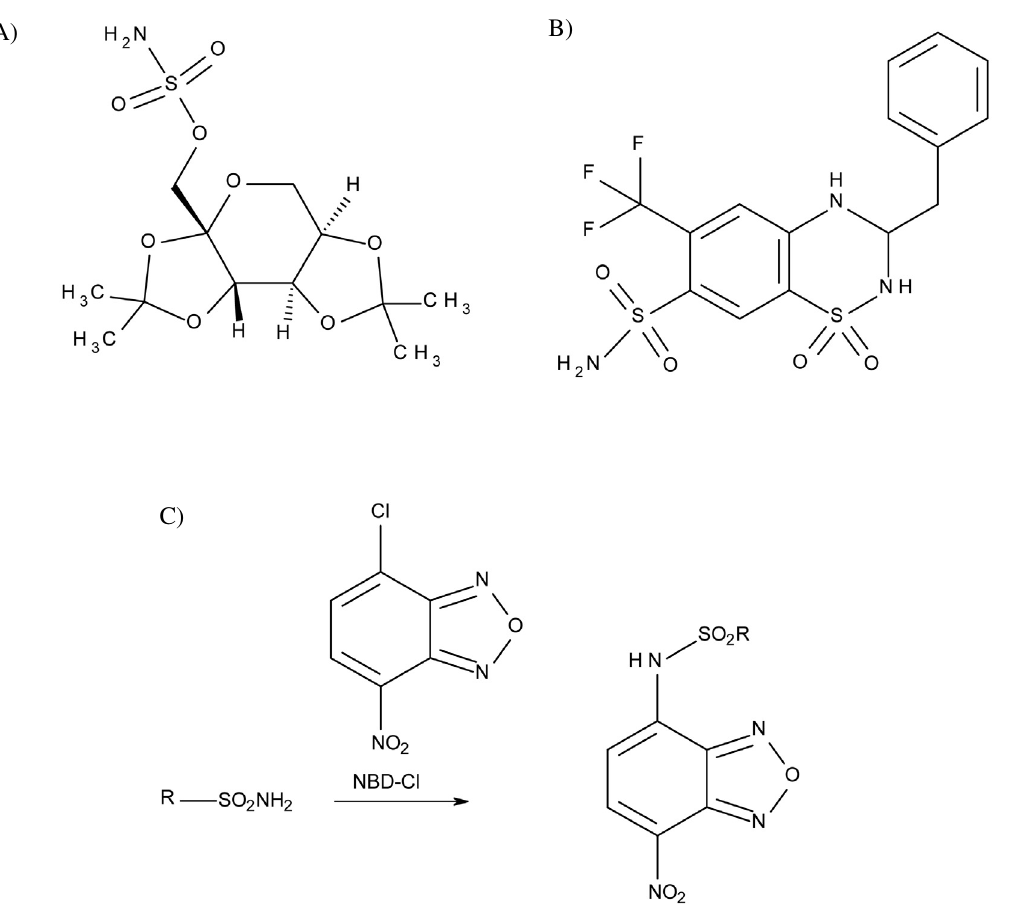
Figure 1 : Chemical structures of A) topiramate, B) bendroflumethiazide (IS) and C) derivatization reaction scheme.